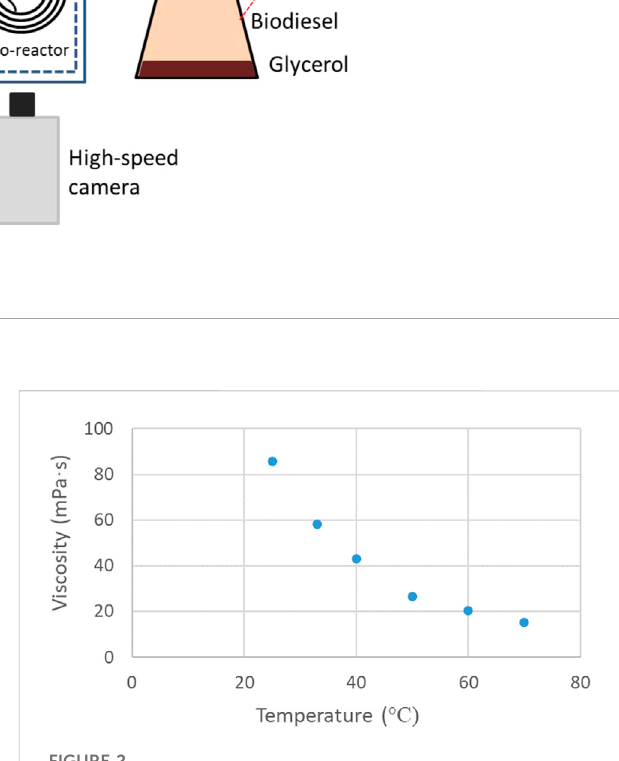
FIGURE 2 Viscosity of waste cooking oil as a function of temperature.